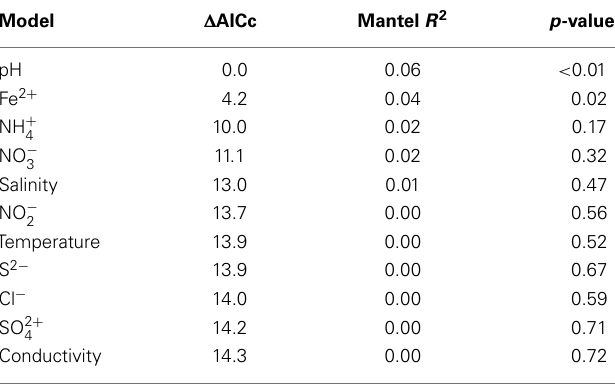
Table 6 | Model ranking using ∆ AICc and Mantel correlation co- efficients ( R 2 ) where archaeal 16S rRNA gene Rao among community phylogenetic distance is the response